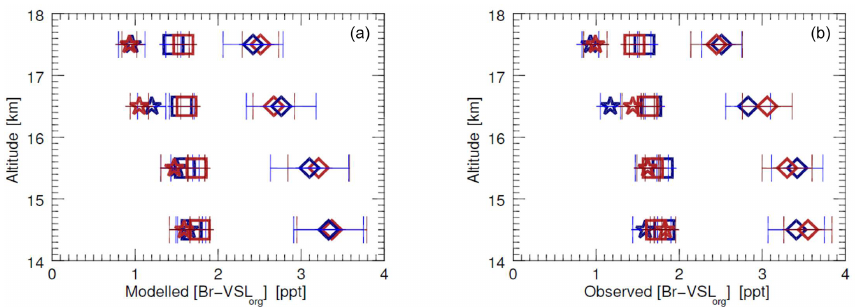
Figure 9. Contribution of CHBr 3 (star symbol) and CH 2 Br 2 (square symbol) to the bromine budget in the TTL, inferred from the NAME- modelled estimates (a) and AWAS observations (b) ; ATTREX 2014 (red) and 2013 (blue) are shown separately. Stars and square symbols represent the bromine atomicity products from CHBr 3 and CH 2 Br 2 , respectively. Diamonds show the bromine contribution from the VSL bromocarbons in the TTL (as a sum of the CHBr 3 and CH 2 Br 2 bromine atomicity products).